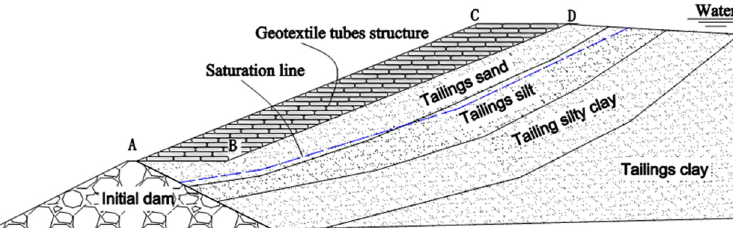
Figure 2: Schematic of a cross - section of tailings dam constructed with geotextile